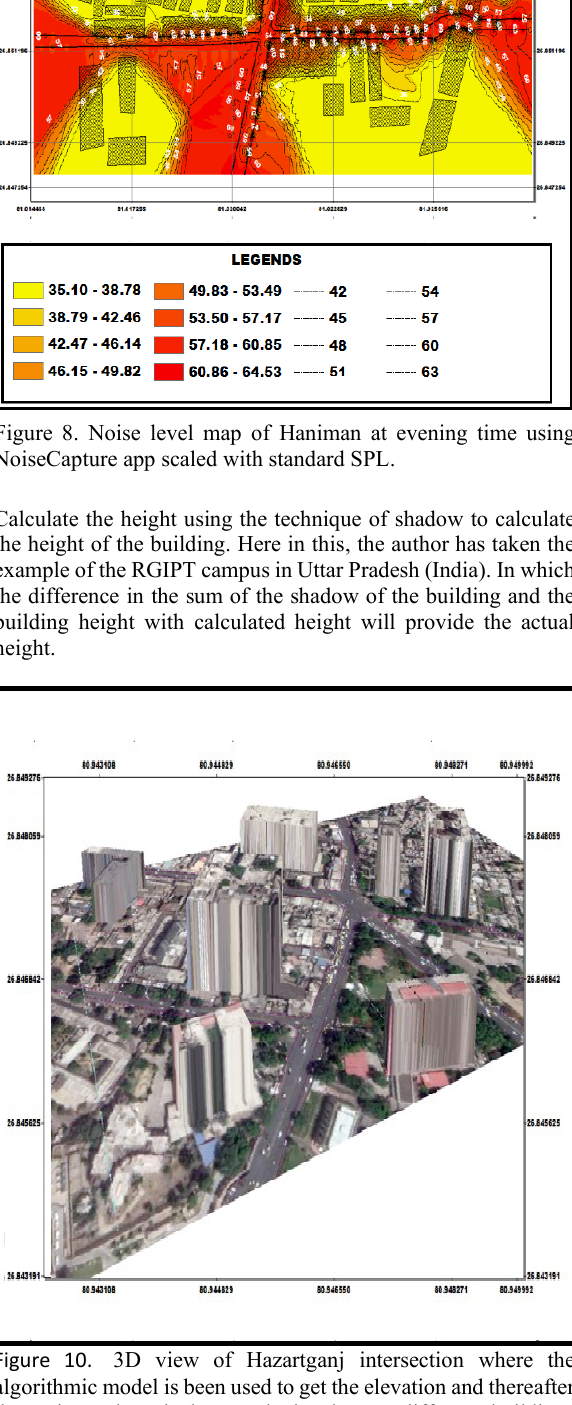
Figure 8. Rgipt google image for estimating height through shadow. for